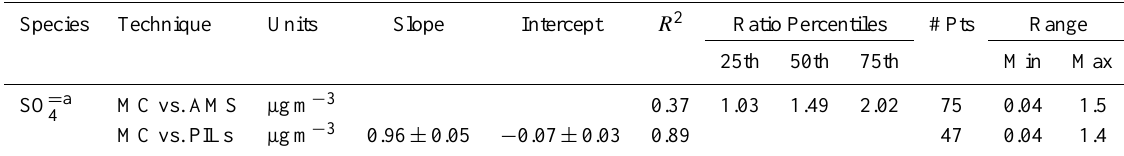
Table 3h. Statistical results of DC-8/C-130 intercomparison. Particle chemical composition. NOTE: Technique is listed as X (C-130) vs. Y